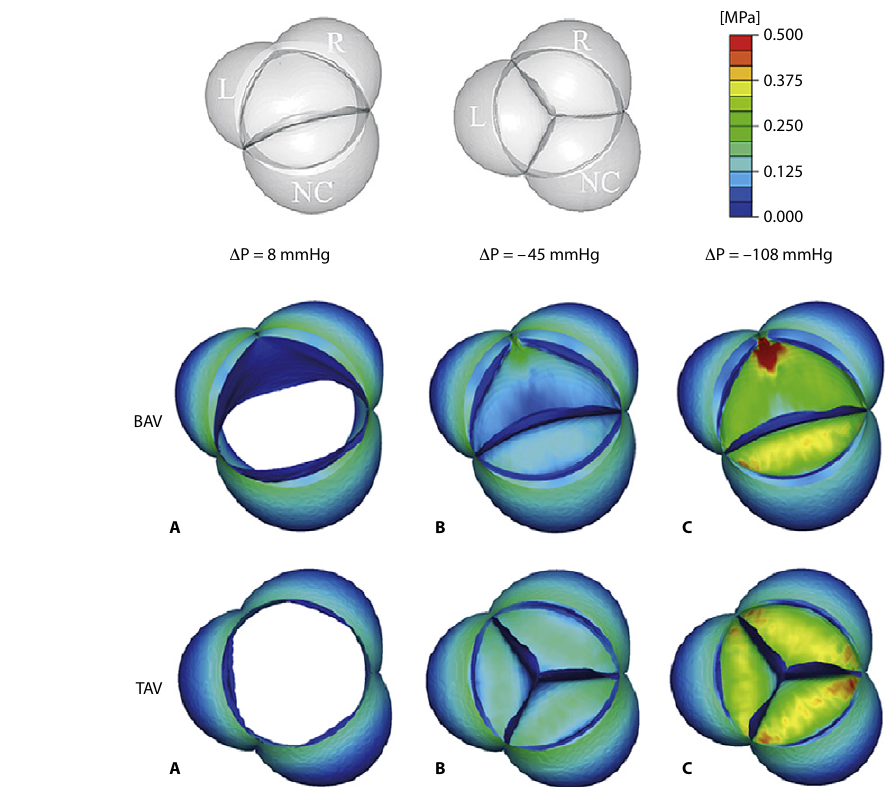
Figure. 6 Tensile stress (principal stress) distributions on aortic root and valve tissue of hypothetical aortic root models [102]. Focal high stress is observed around the leaflet commissures in closed leaflet configurations and the stress concentration is higher for the bicuspid aortic valve (BAV) model around the leaflet fusion where calcifiedsiteistypicallyobserved[98].ReprintedfromContietal.JThoracCardiovascSurg140,890–896(2010) with permission from